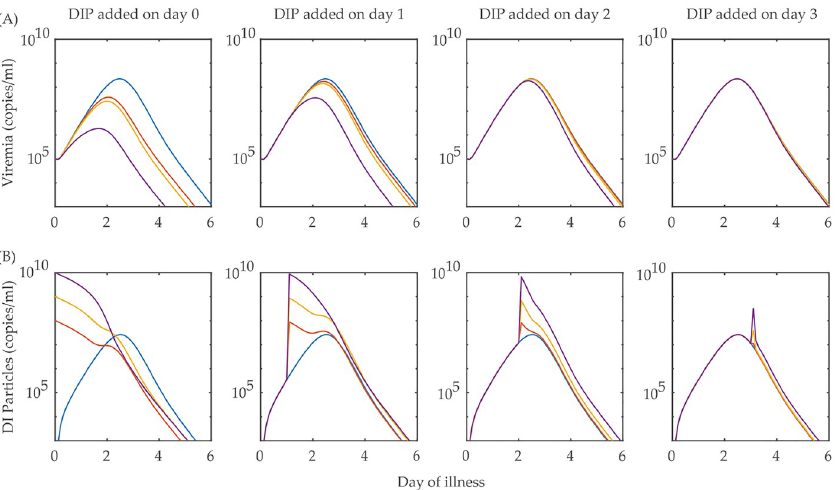
Fig 6. Single time point DI particles (DIP) treatment. Different doses of excess DI particles are added to a within- host dengue viral infection model at different single time points. The effect of the treatment are shown by the dynamics of (A) viraemia and (B) DI particles. The blue lines represent the trajectories of virus and DI particles without applying the treatment of adding DI particles. The lines in red, yellow and purple are the corresponding virus and DI particles dynamics with the addition of 10 8 , 10 9 and 10 10 copies of DI particles, respectively on 0, 1, 2 and 3 days of illness. Although a very high dose (10 10 ) of DI treatment on day 0 of the illness can reduce the treated viraemia peak by approximately 100 fold and also the duration of illness, the same dose becomes less effective if applied on days 1, 2 and 3 of illness. The other doses of 10 8 and 10 9 do not show notable efficiency, even if applied on day